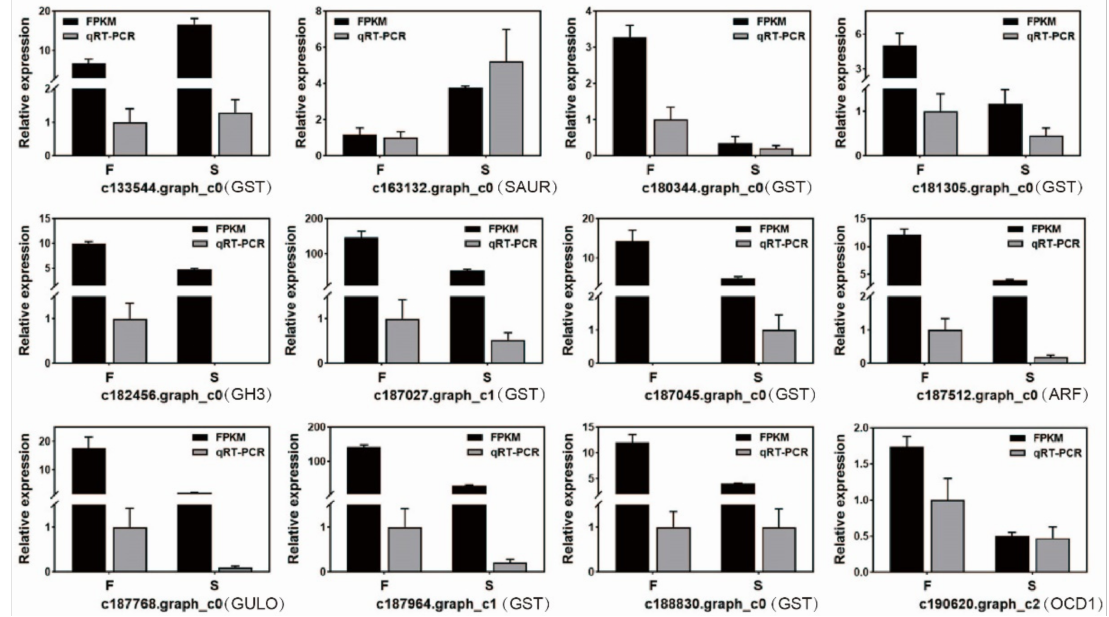
Figure 5. qRT-PCR analysis of differentially expressed genes between F and S cell lines of Korean pine. Note: The average three biological replicates were counted for each treatment, and ANOVA was performed on the data in the figure, mean ±